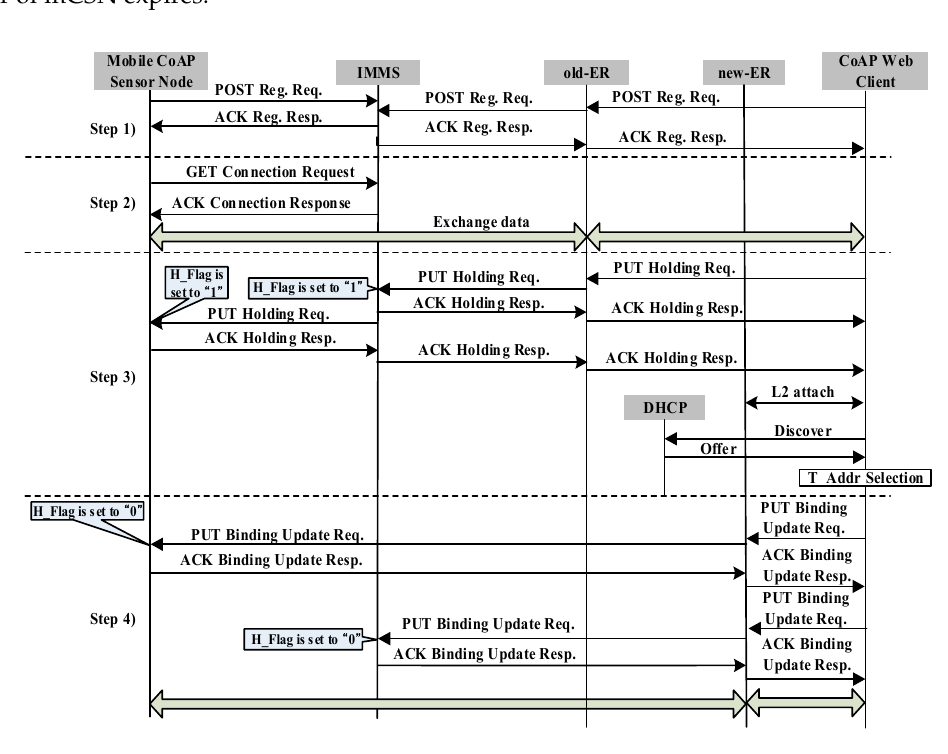
Figure 2. Signaling flow diagram of CoMP.